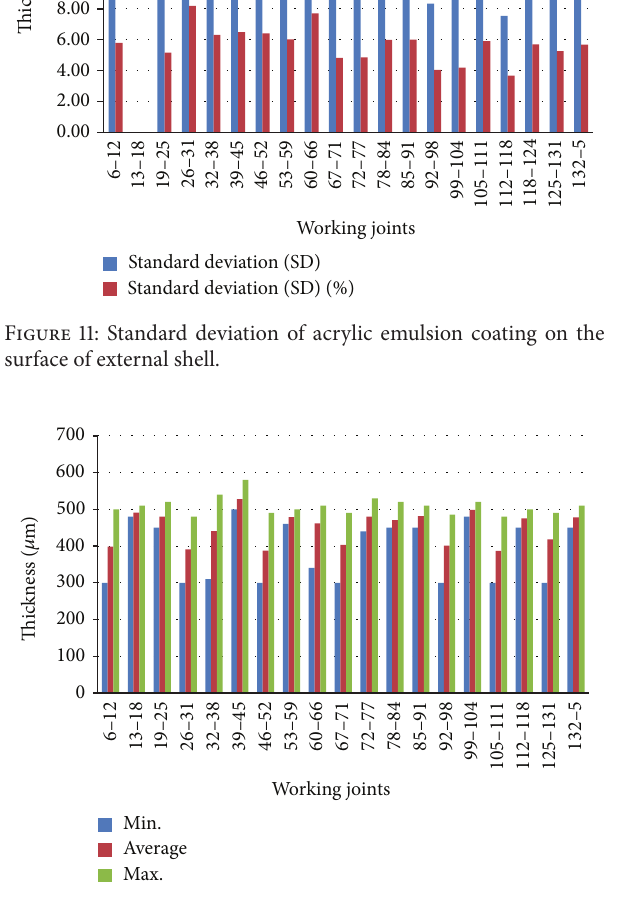
Figure 12: Total thickness of organic coatings ( 𝜇 m) on the surface of concrete internal shell (above the ring).